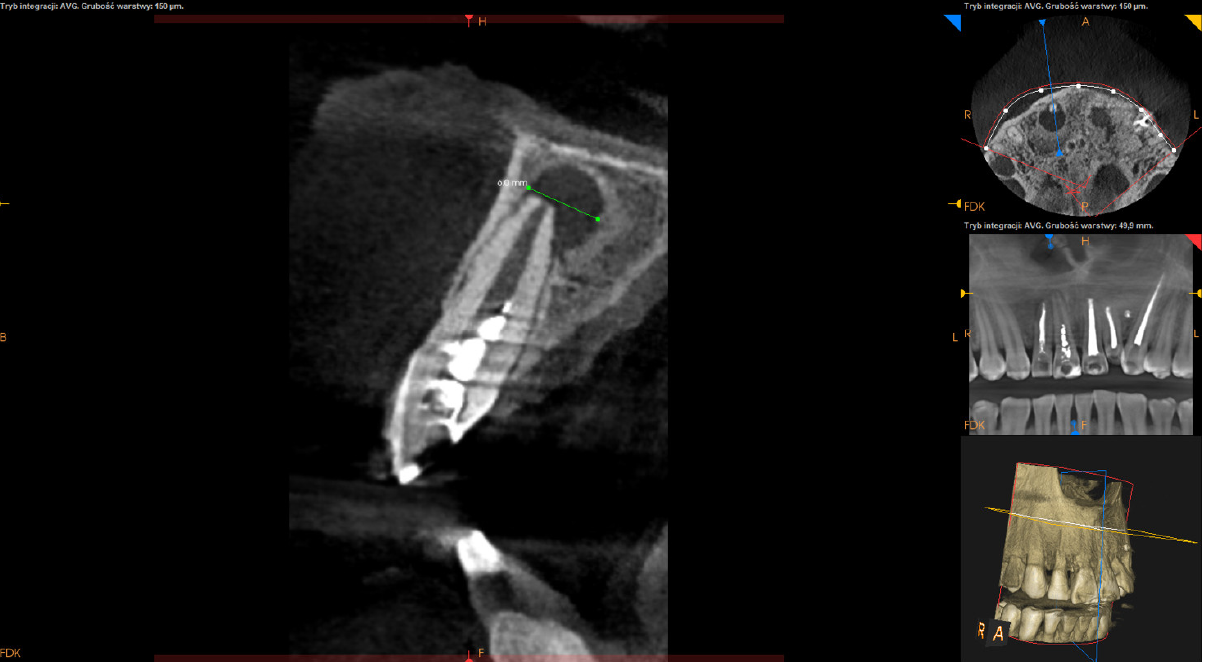
Figure 3. CBCT image (CS 8100 3D Carestream Dental ® ) measurement of buccolingual maximum diameter in sagittal section. Non-English annotations present software technicalities (AVG integration mode and the layer thickness).